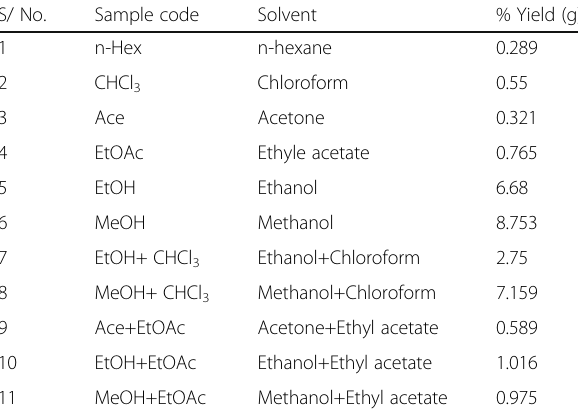
Table 1 A. jacquemontii extraction in different organic non polar to polar solvent with percent yield S/